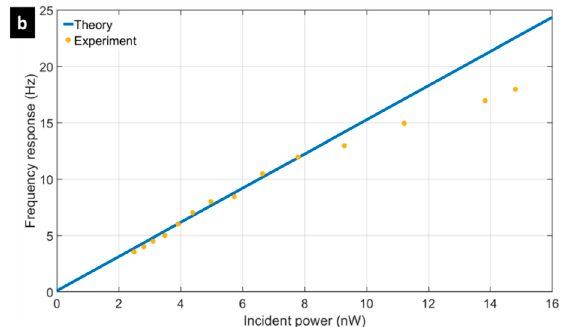
Figure 8. Measurement of the thermal response: ( a ) Resonance frequency shift induced by incident IR pulses (peaks of 17 nW); ( b ) Frequency shift when the incident power is varied from 2 to 16 nW. Similar experimental thermal responses were extracted on other pixels of a same array. From one array to another, experimental R f varied from 700 to 1350 W − 1 , showing some dispersion attributed to the fabrication process.